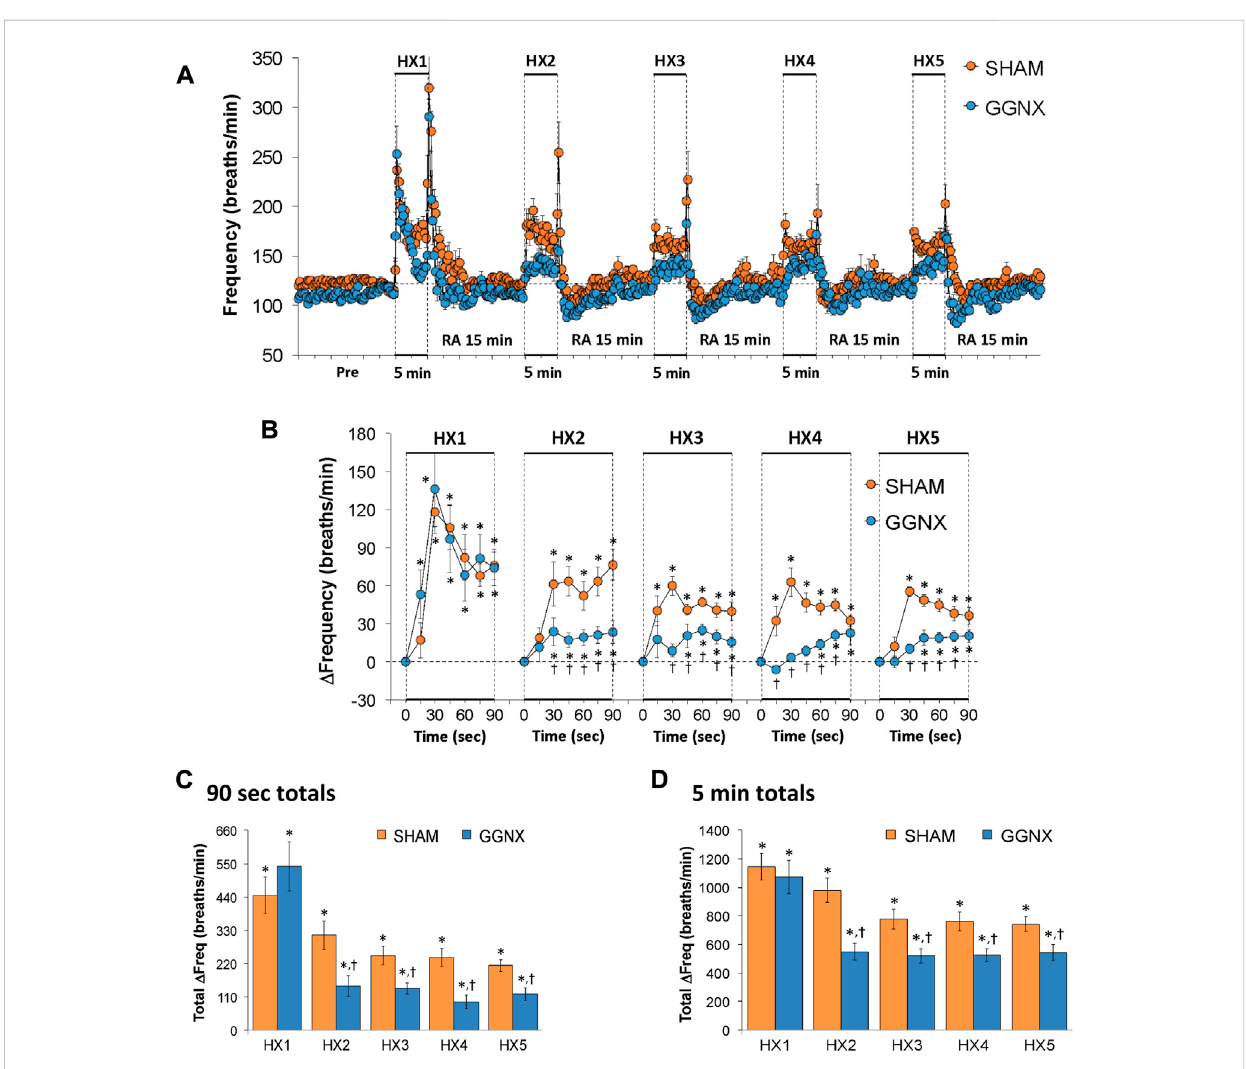
FIGURE 2 (A) Frequency of breathing in sham-operated (SHAM) rats and in rats with bilateral ganglioglomerular nerve transection (GGNX) before (Pre) and during fi ve hypoxic (HX, 10% O 2 , 90% N 2 ) gas challenges, each separated by 15 min of room-air (RA). (B) Arithmetic changes in frequency during the fi rst 90 s of HX gas challenge. (C) Total changes in frequency during the fi rst 90 s of HX gas challenge. (D) Total changes in frequency during the entire 5 min of HX gas challenge. The SHAM group had 10 rats. The GGNX group had 12 rats. The data are presented as mean ± SEM. * p < 0.05, signi fi cant response. † p < 0.05, GGNX rats versus SHAM